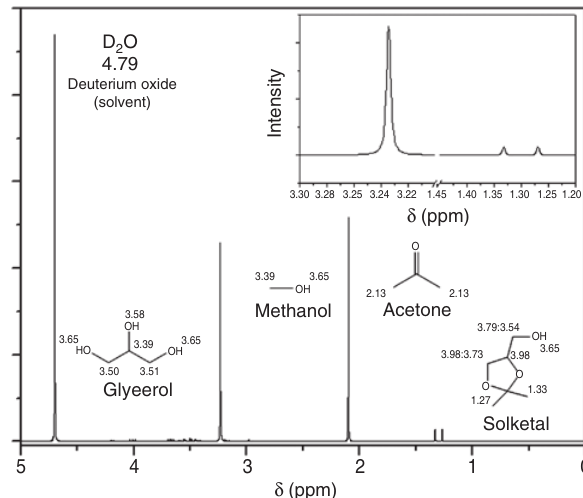
Figure 2: Representative 1 H-NMR spectrum 300 MHz spectra of a sample of the reaction with all the chemical components and shifts for the corresponding protons